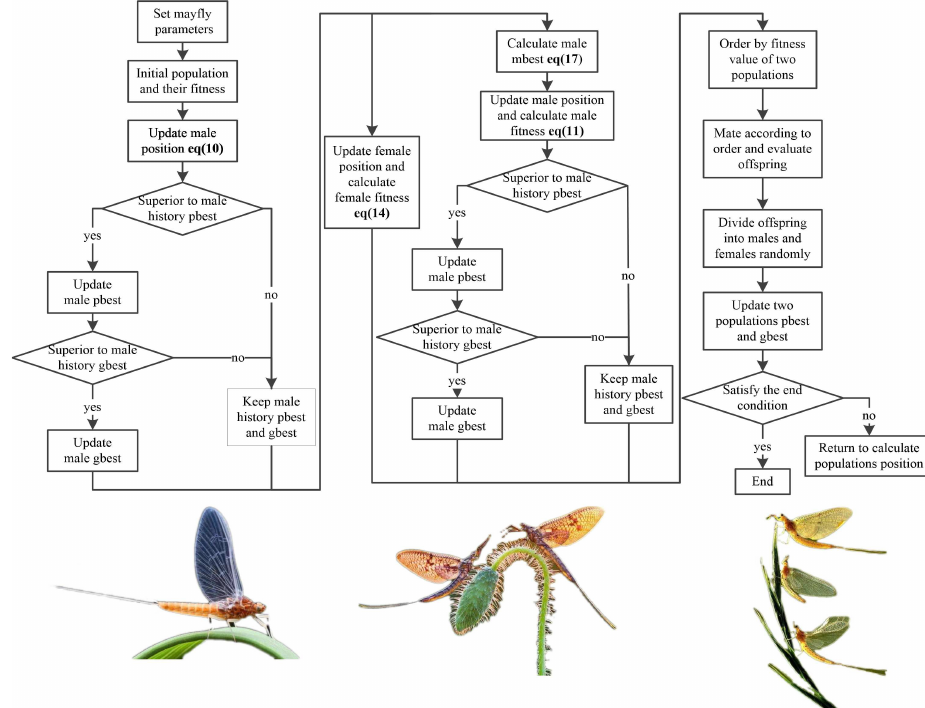
Figure 4. The flow chart of QMA.